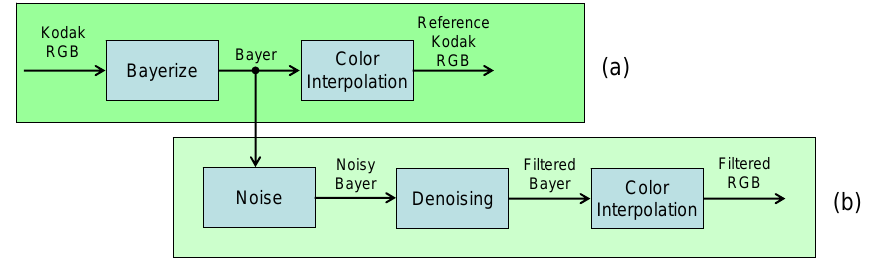
Figure 19. Testing procedure. (a) The original Kodak color image is converted to Bayer pattern format and demosaiced. (b) Noise is added to the Bayer image, filtered and color interpolated again. Hence, color interpolation is the same for the clean reference and the denoised images.